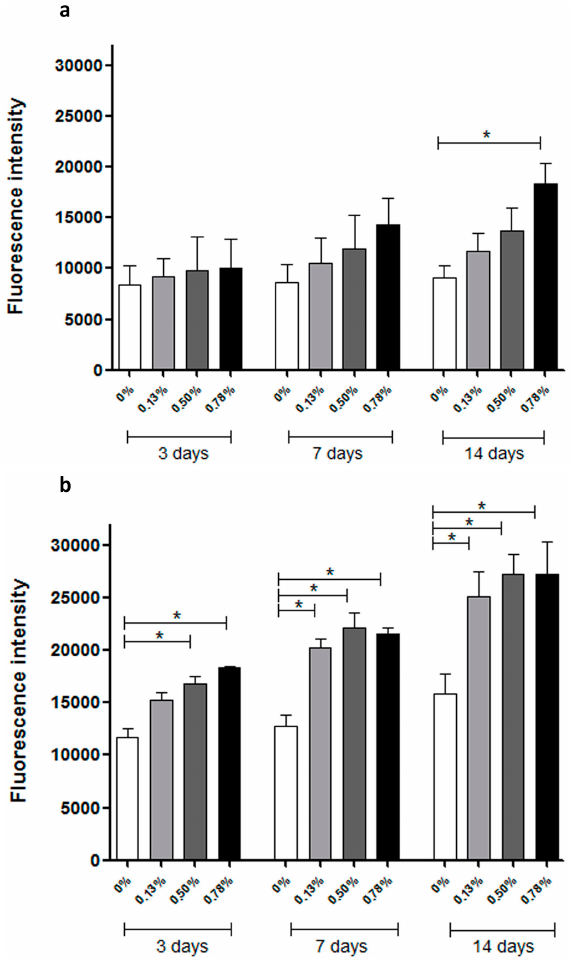
Figure 3. Cell viability/proliferation (Fluorescence intensity) after 3, 7, and 14 days of cell seeding. ( a ) Untreated scaffolds; ( b ) NaOH-treated scaffolds. * Statistical evidence ( p < 0.05) analysed with a one-way ANOVA and Tukey’s post-hoc test.